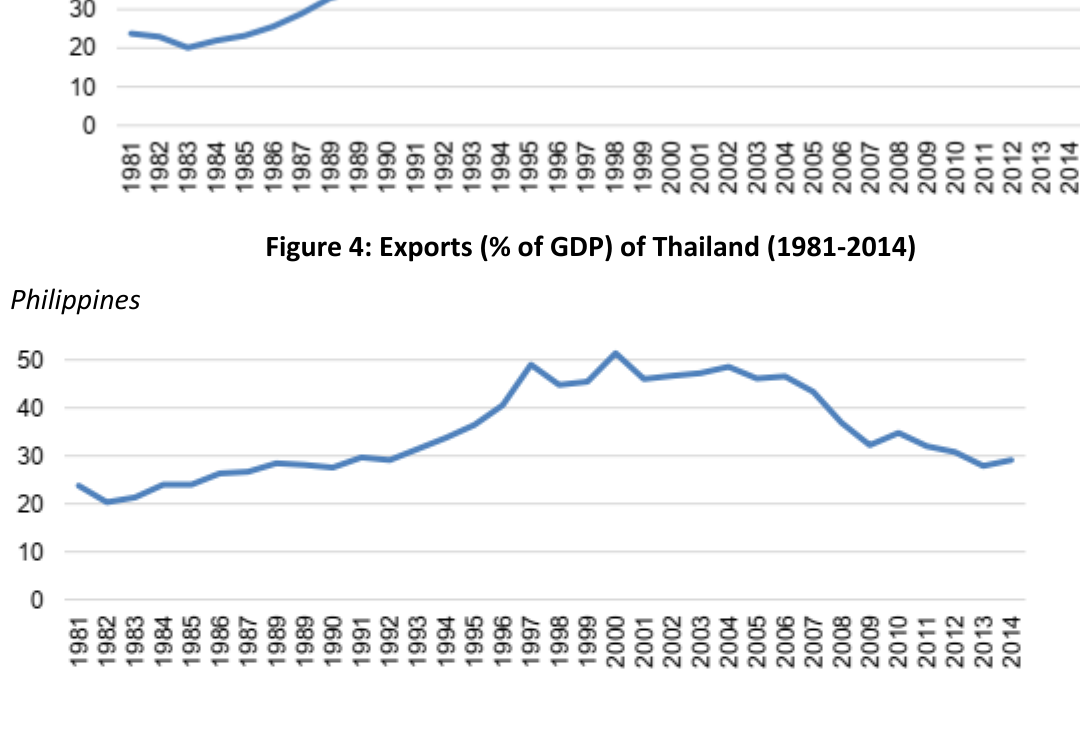
Figure 5: Exports (% of GDP) of The Philippines (1981-2014)